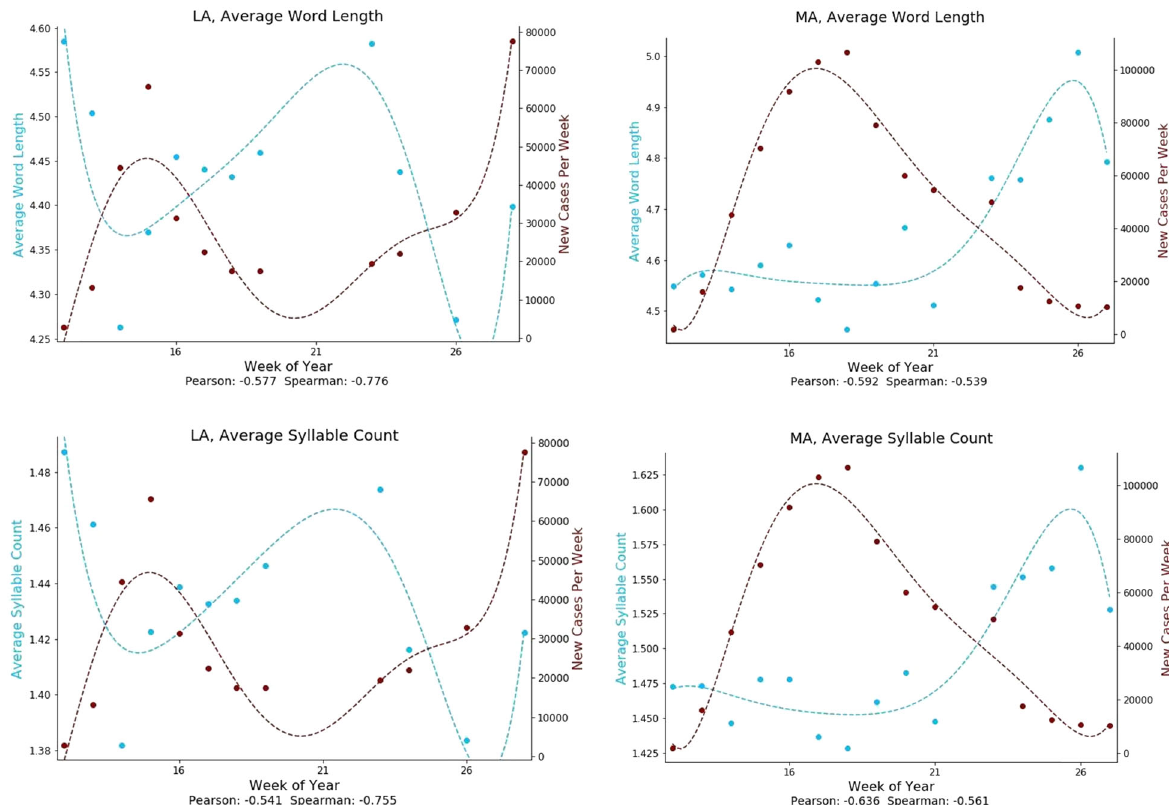
Fig. 8 Temporal associations of linguistic complexity measures with COVID-19 case rates. Both word length and syllable count were negatively associated with COVID-19 case rates over time. States are represented by standard two-letter